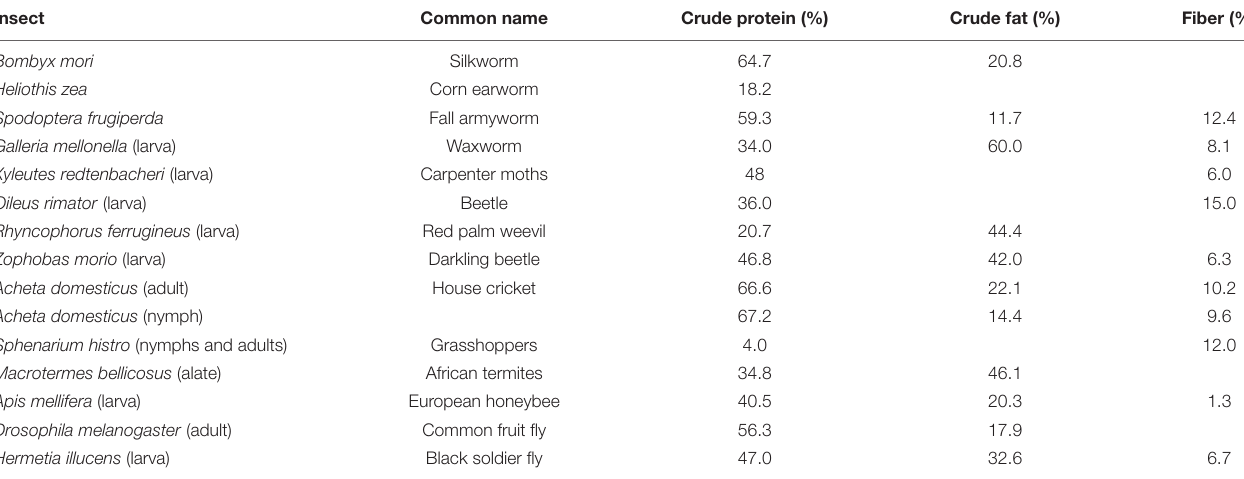
TABLE 1 | Composition of insects used as a protein source in the human feed (based on Williams et al.,